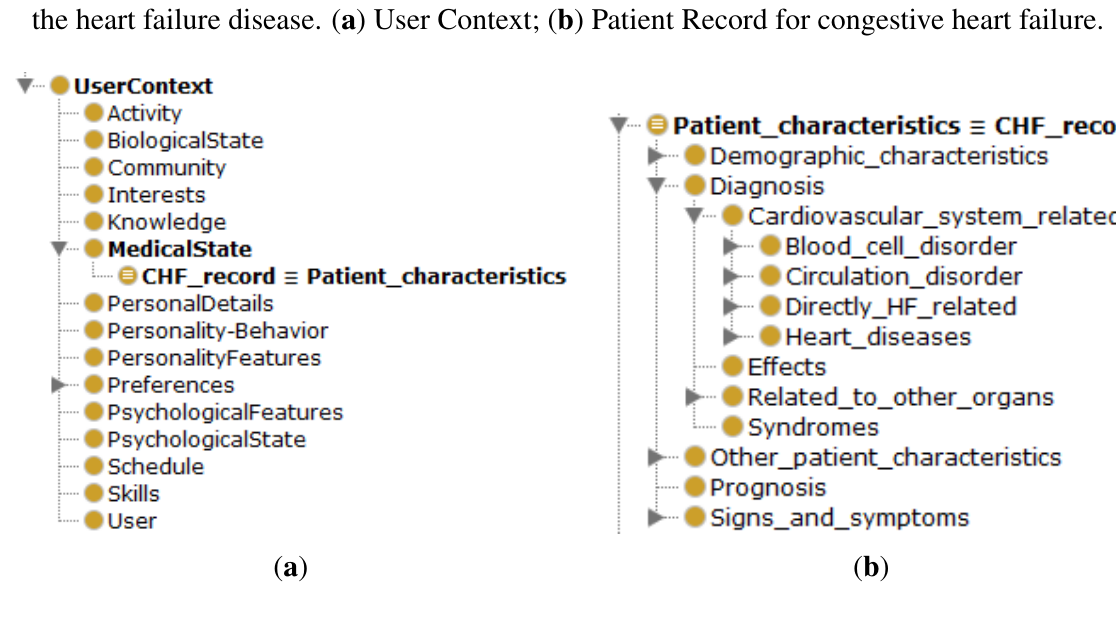
Figure 7. Ontological definition of a patient’s medical state according to a specific model